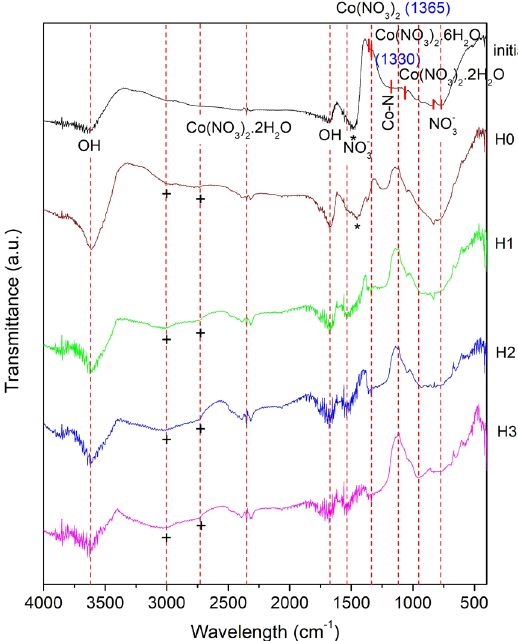
Figure 6. FT-IR spectra of CoNHH in the range of 400–4000 cm -1 for the initial sample, and for the samples after thawing-freezing in different magnetic fields of: H